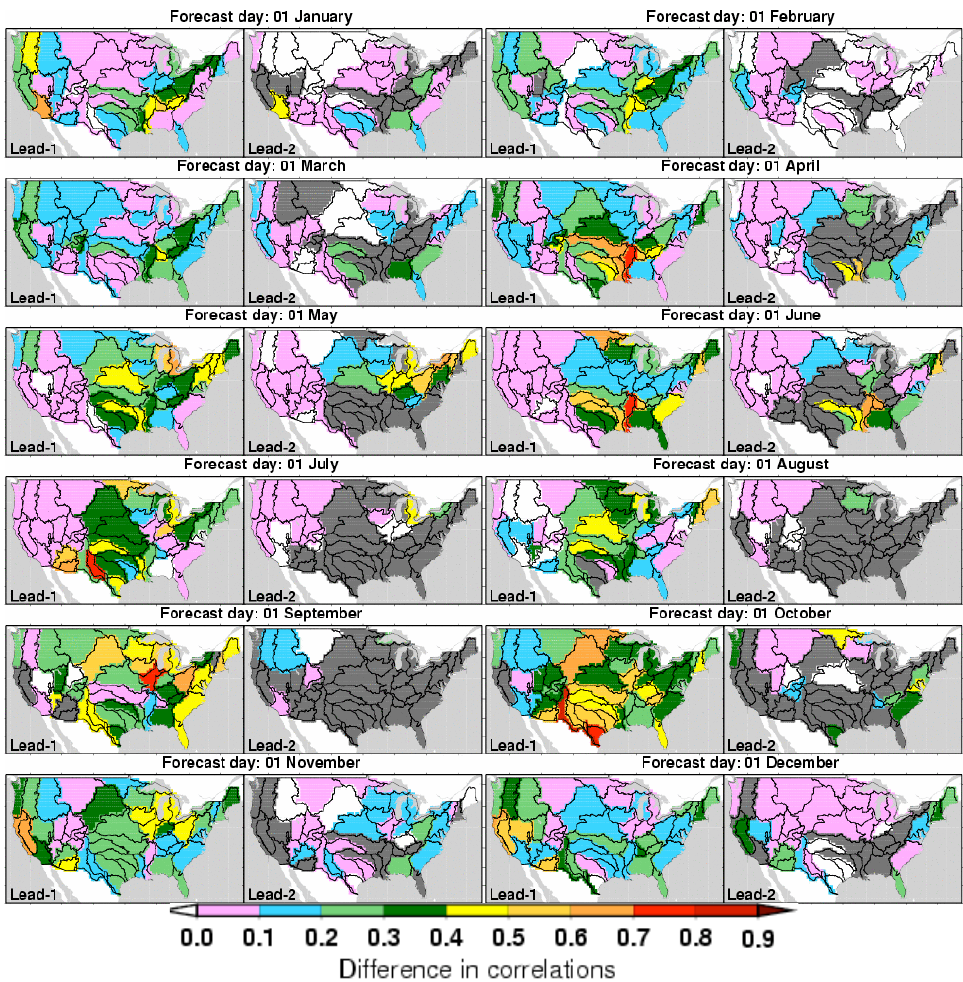
Figure 5: Potential improvement in runoff forecast skills at leads 1-2 months. (Dark grey 3 Fig. 5. Potential improvement in runoff forecast skills at leads 1–2 months (dark grey color shows the sub-regions where the skill of OBS Merged ESP is not significant at the 95% significance color shows the sub-regions where the skill of OBS_Merged_ESP is not significant at 4 95% significance level.) 5